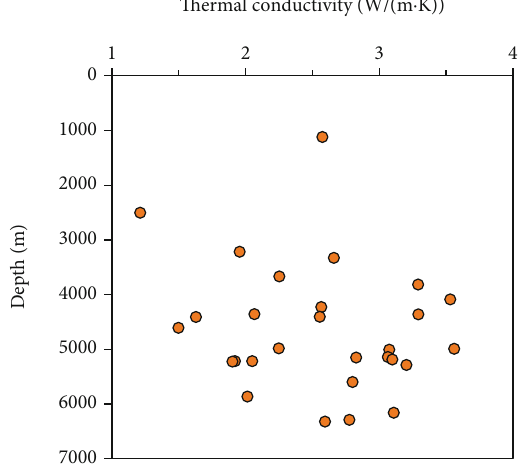
Figure 8: Relation between thermal conductivity of rocks and depth in Tarim